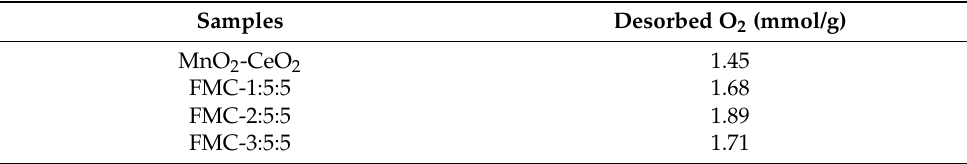
Table 3. Oxygen desorption of FMC samples with different ratios of Fe/Mn/Ce. Samples